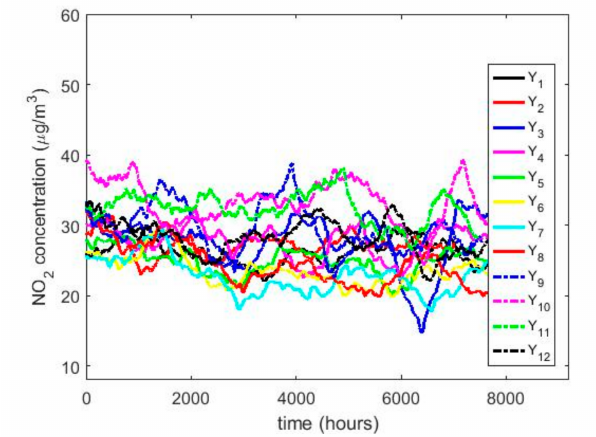
Figure 8. Moving average of the NO 2 concentrations: Y 1 (January), Y 2 (February), Y 3 (March), Y 4 (April), Y 5 (May), Y 6 (June), Y 7 (July), Y 8 (August), Y 9 (September), Y 10 (October), Y 11 (November), and Y 12